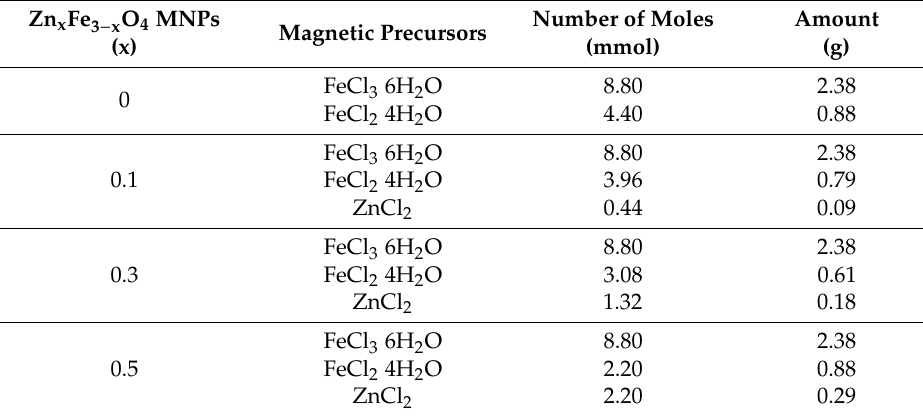
Table 4. Amounts of magnetic precursors used in the synthesis of